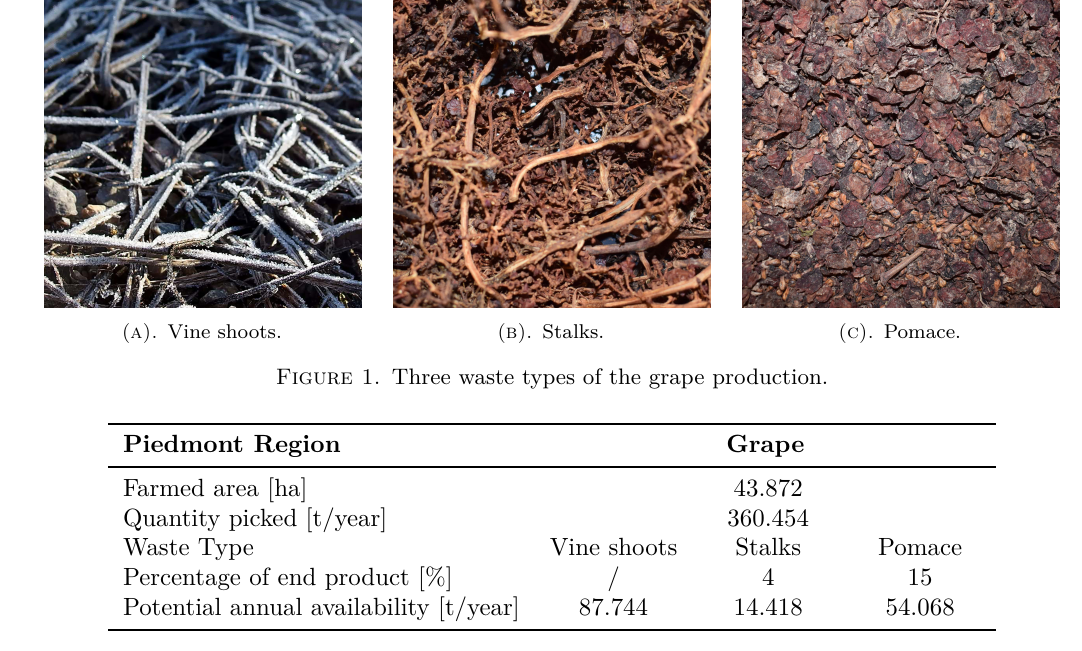
Table 1. Synoptic framework of the grape supply chain in